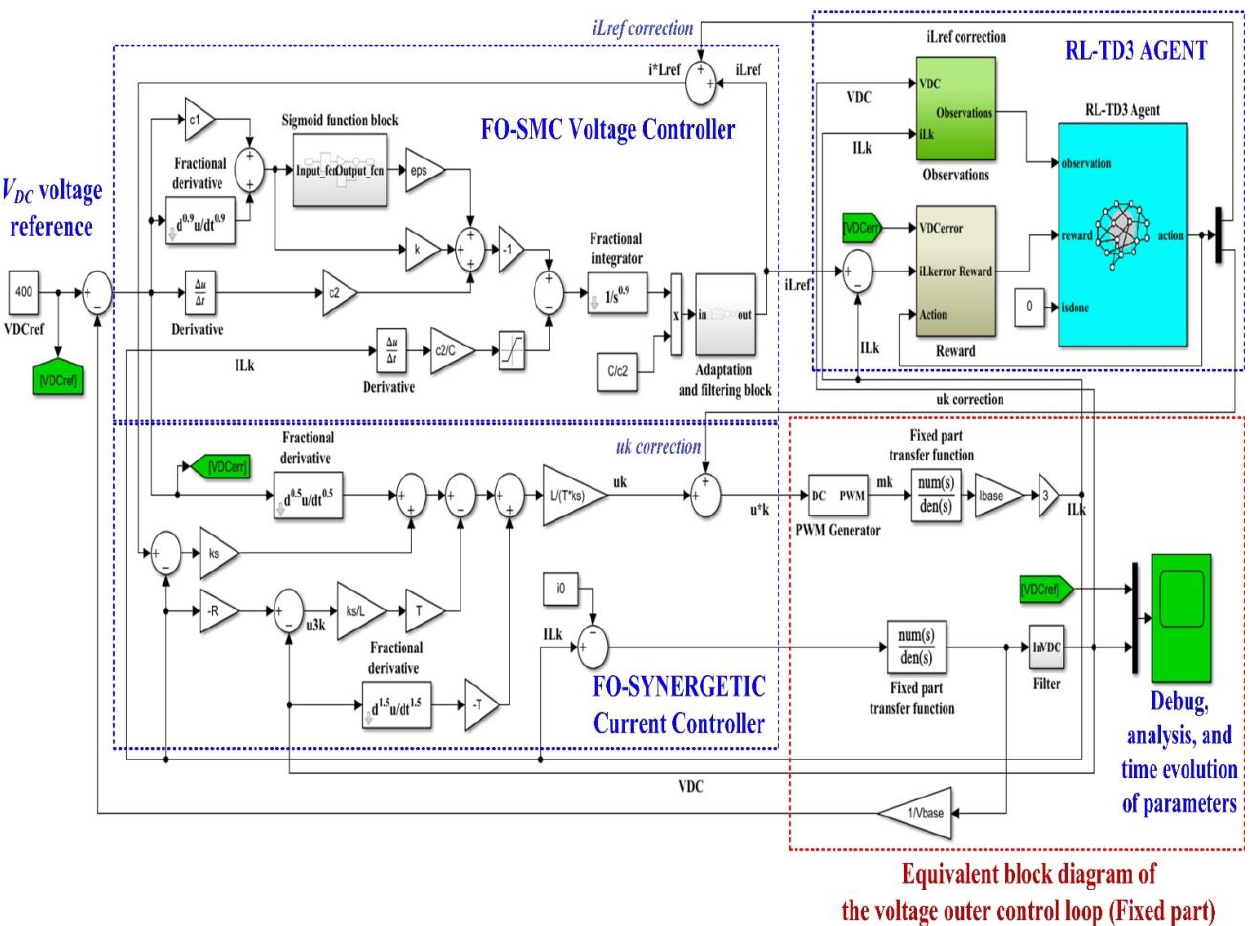
Figure 16. Matlab/Simulink R2021b implementation for the control systems of the power electronic converter using the FO SMC controller for the voltage outer control loop and the FO synergetic controller for the current inner control loop combined with the RL-TD3 agent.